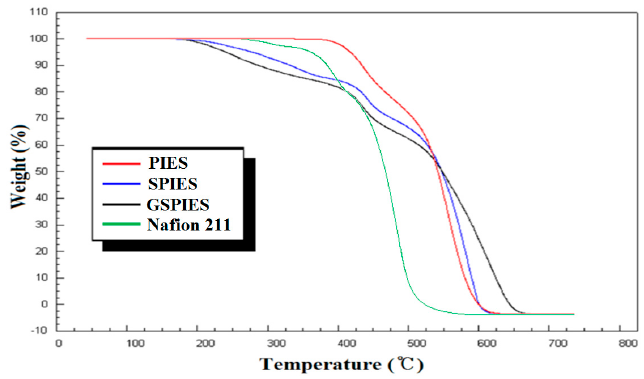
Figure 5. Thermooxidative stabilities of PIES, SPIES and GSPIES.